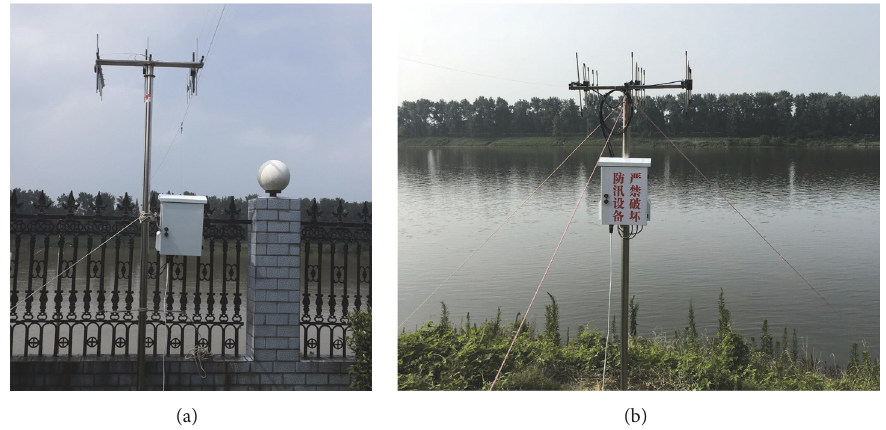
Figure 10: Dual OSMAR-SUs is deployed on the bank of Hanjiang